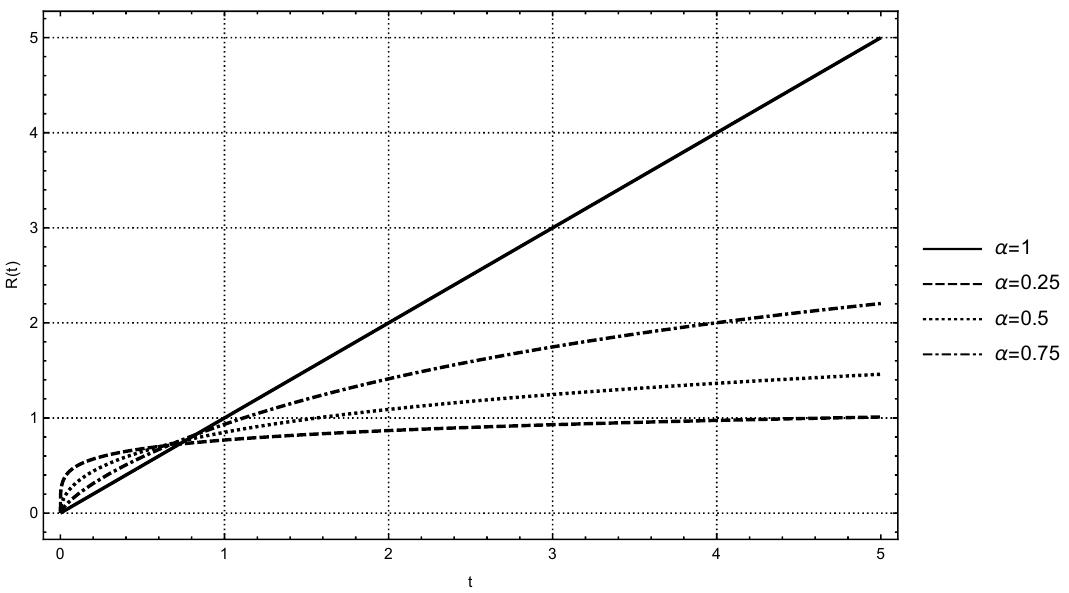
Figure 4. Plots of R α ( t ) = − log [ Ψ α ( t )] for α = 0.25,0.5,0.75,1 versus t ∈ [ 0,5 ]